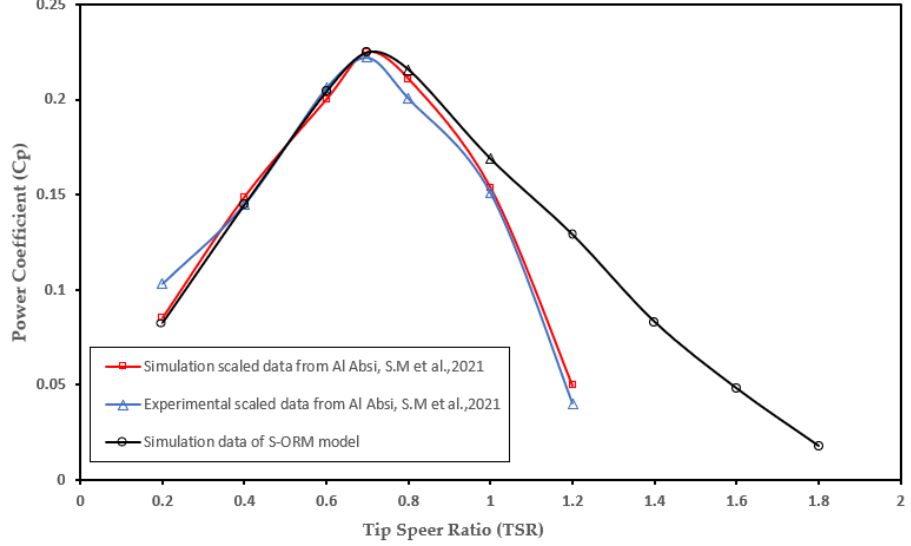
Figure 10. Variations in the scaled Cp S for the S-ORM, along with the original